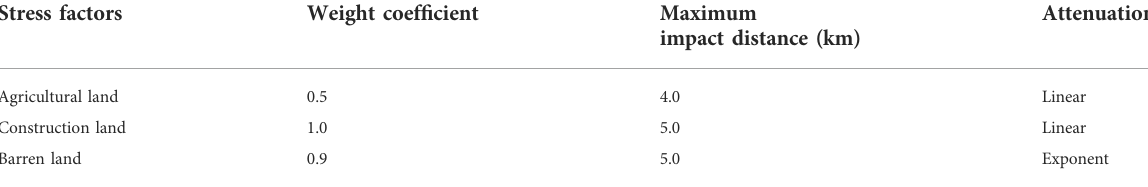
TABLE 4 Stress factors and their stress intensity.